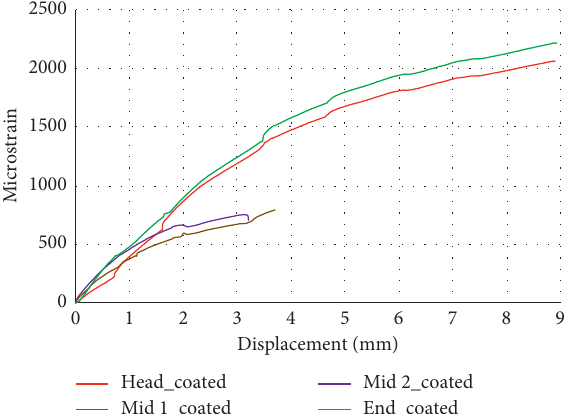
Figure 21: Strain vs. displacement for coated GFRP rock bolt sensor fixed with